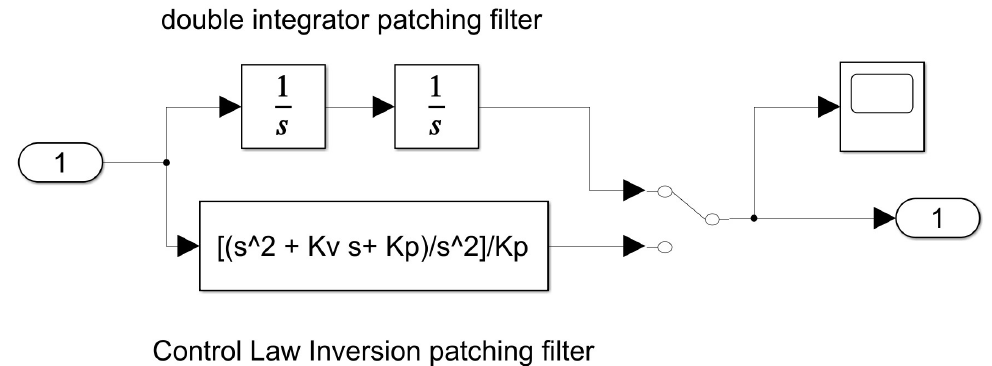
Figure A7. Simulink implementation of patching filters. A manual switch is present to switch between a simple double-integrator patching filter and a control law inversion patching filter.